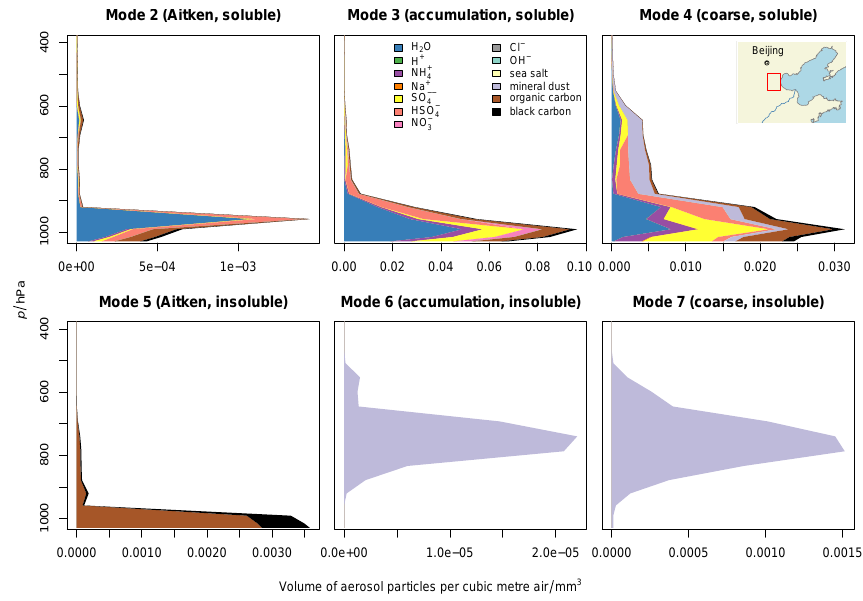
Figure 7. Vertical profiles of the aerosol concentrations in six modes over China which have been used as input for the column model when computing the optical properties in Fig. 8. The red rectangle in the inset of the top right figure depicts the area covered by the model column.